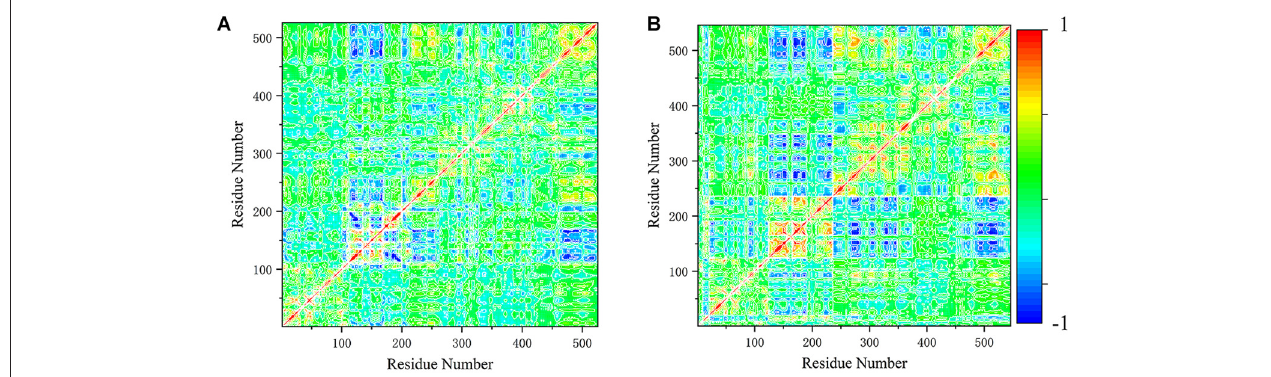
FIGURE 6 | The cross-correlation map of system SHP2 (A) and DUAL (B) . The covariance values are within the range of − 1 to 1, where the extreme positive values (1) reflect the pairs of residues moving in the same direction (red color). And the negative values ( − 1), where the extreme value reflect those residues moving in opposite direction (blue